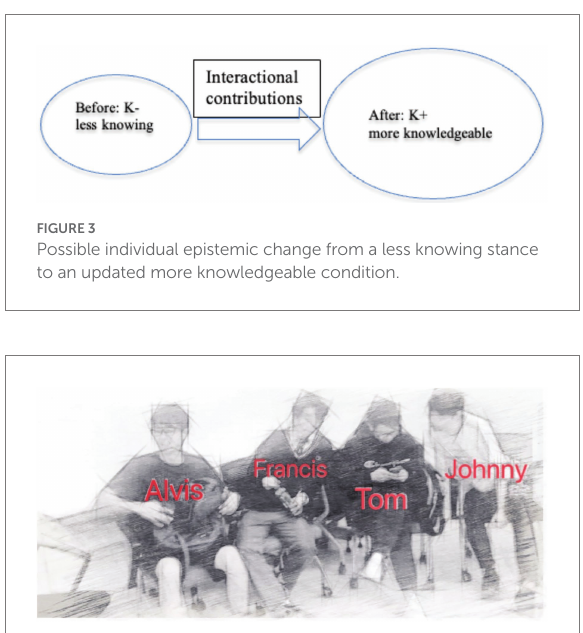
FIGURE 4 Frozen action: looking at the phone